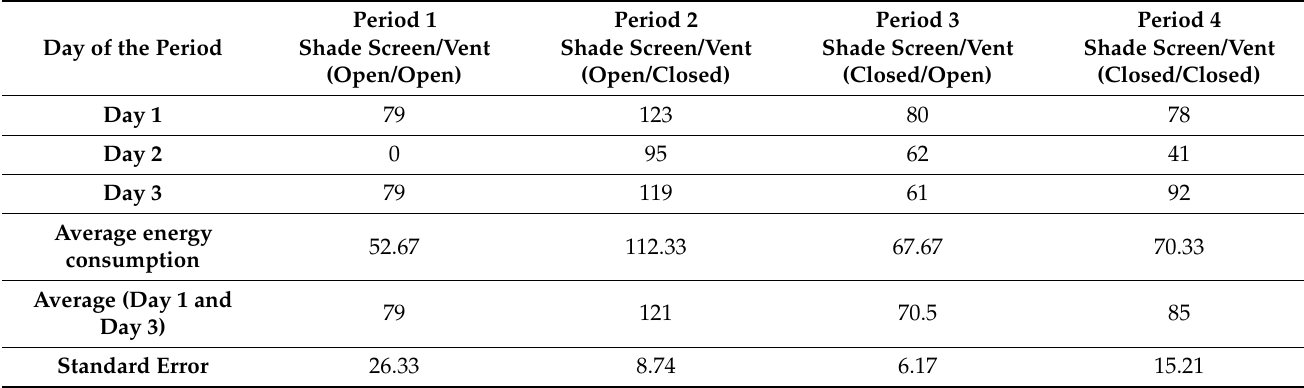
Table 3. Daily and average energy consumption (kWh) in different statuses of vents and shade screens in the greenhouse compartment.